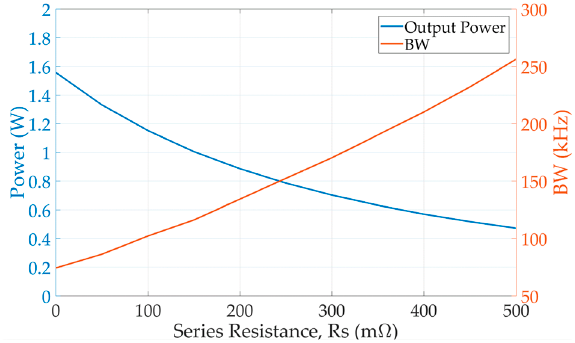
Figure 4. Variation in bandwidth and output power with respect to series resistance.